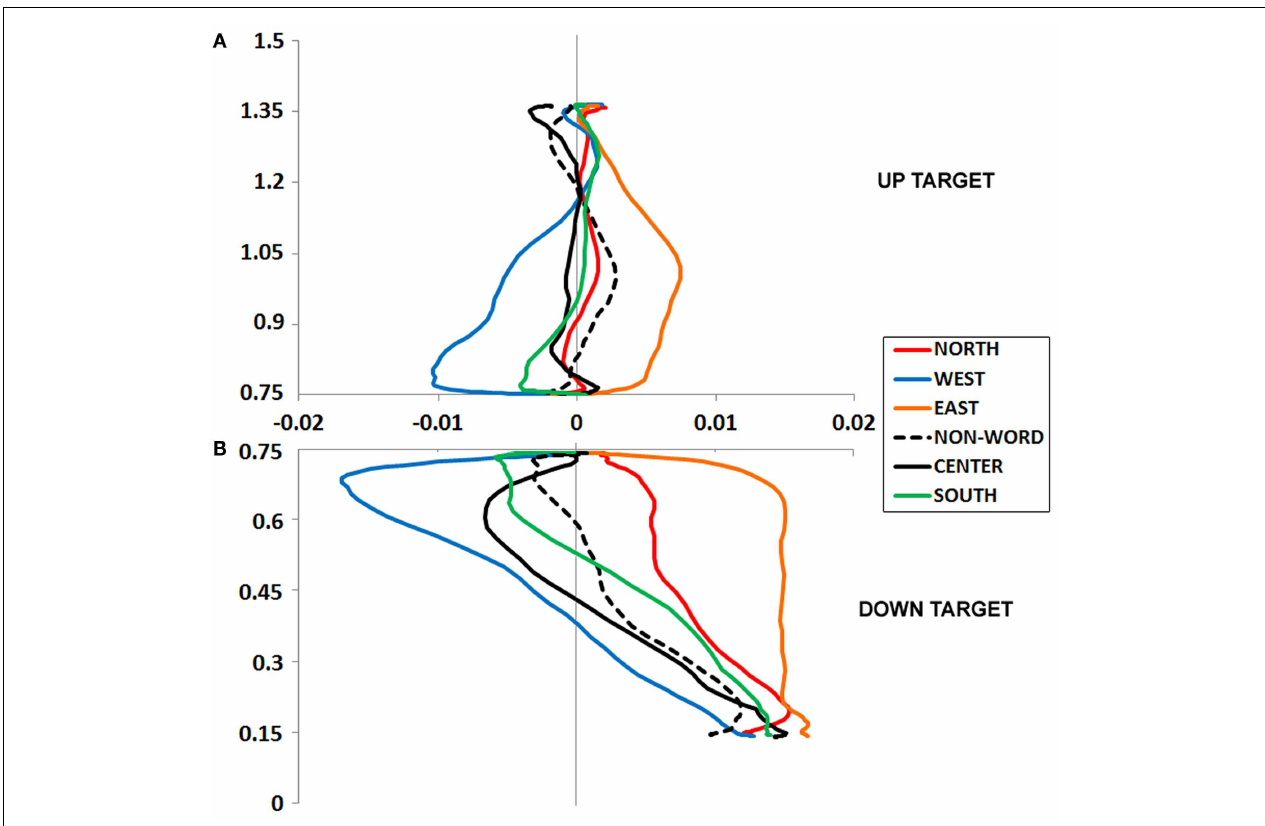
FIGURE 2 | (A,B) Experiment 1 plotted movement trajectory data for the Up (A) and Down (B) target locations, for each of the six PrimeTypes.